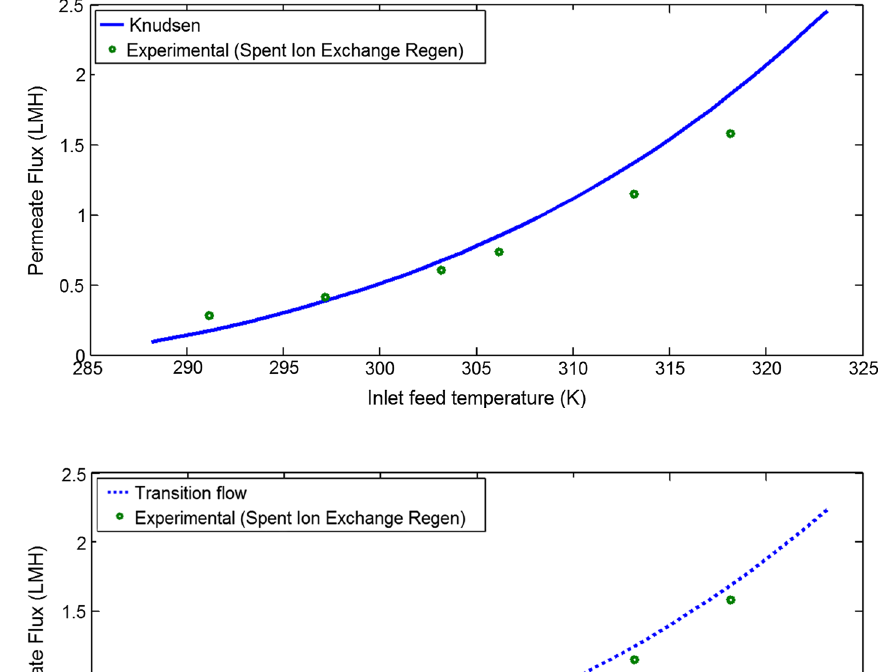
Fig. 11 Knudsen diffusion theoretical model best predicted the membrane performance of the industrial RO